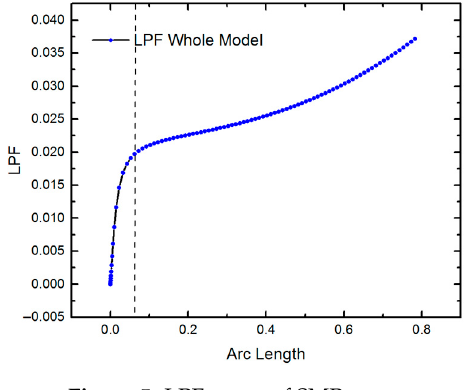
Figure 5. LPF curve of SMP stent. Table 4. First order static buckling load of SMP stents with di ff erent values of